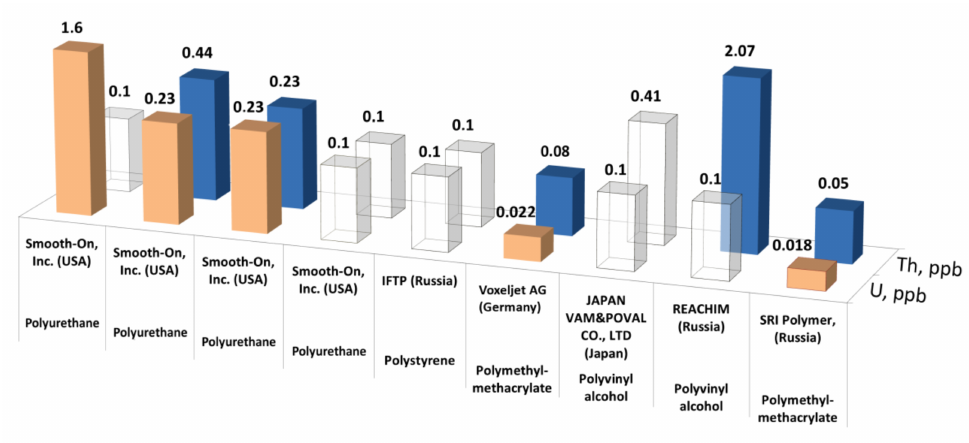
Figure 6. The determined concentration of thorium and uranium in commercial polymers. The empty cubes correspond to the limits of